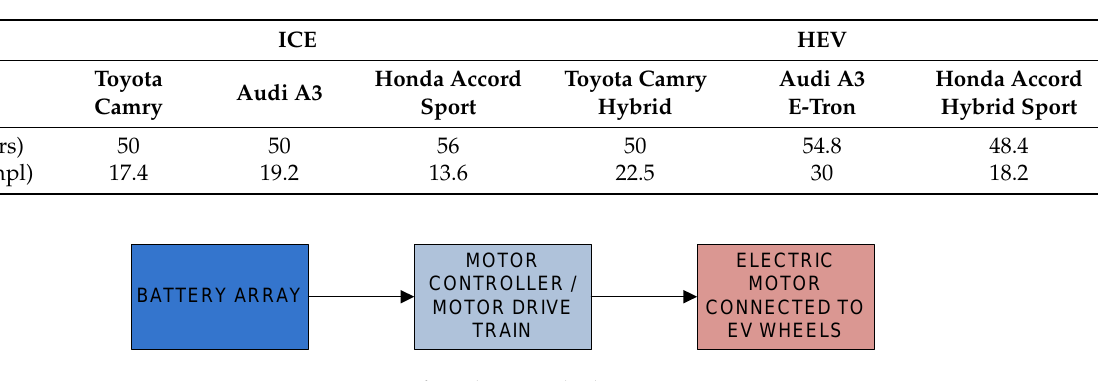
Table 1. Comparison of HEVs and an IC engine.